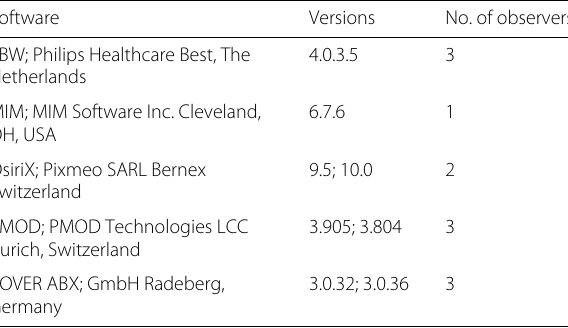
The third column shows the number of observers who applied the respective software to the whole patient